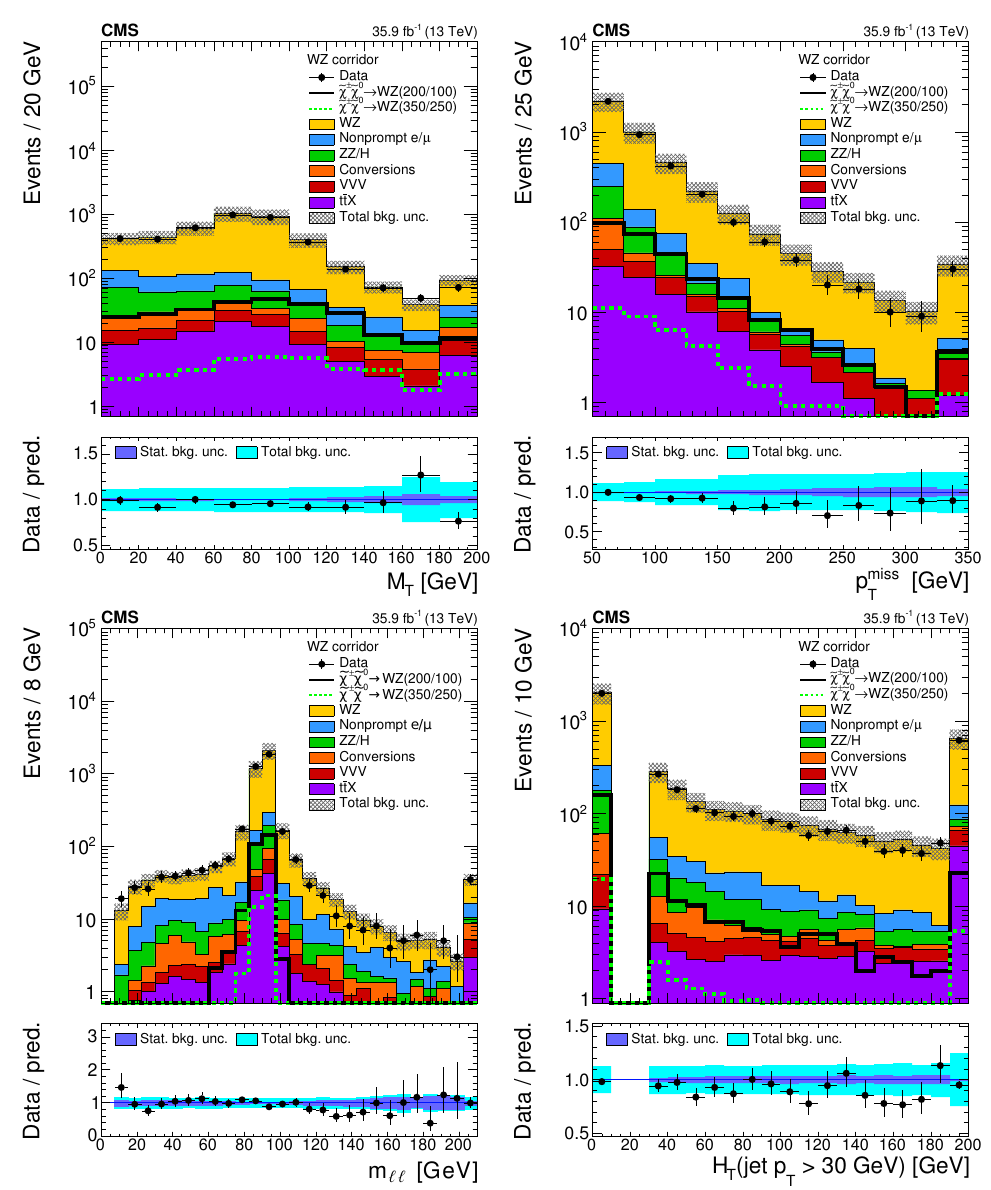
Figure 5 . Distributions of the transverse mass of the third lepton with respect to p miss (upper T left), the p miss (upper right), the m ‘‘ of the OSSF pair (lower left), and the H T (lower right). T Distributions for two signal mass points in the WZ corridor are overlaid for illustration. The mass values for the signal points are given as ( m =m ) in GeV. The bottom panel shows the ratio of e (cid:31) 0 2 e (cid:31) 0 1 observed data to predicted yields. The dark purple band shows the statistical uncertainty in the background prediction, while the light blue band shows the total